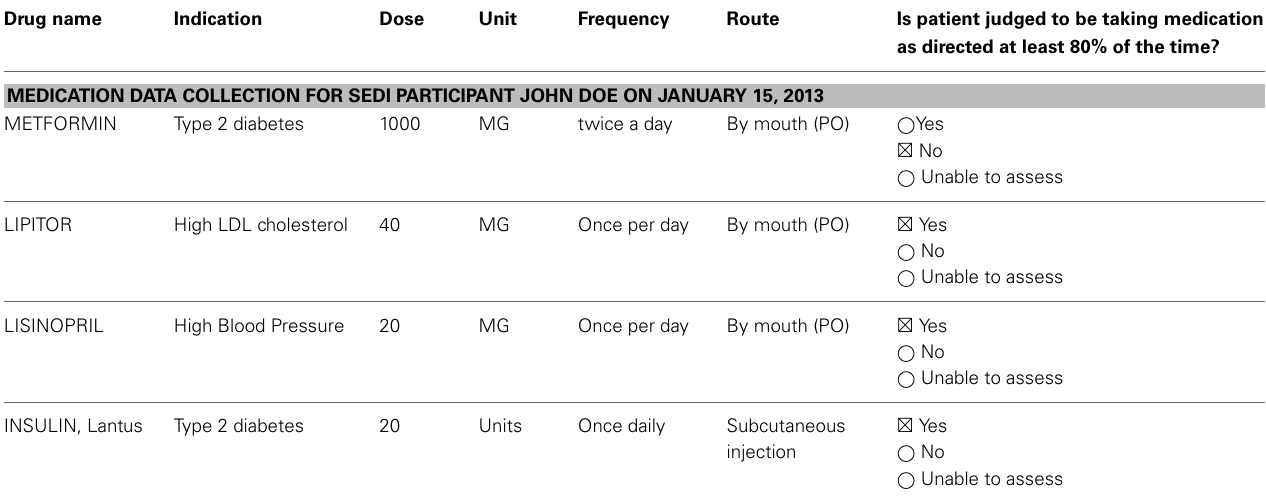
Table 2 | Example patient data for SEDI MEDICATION LOG data